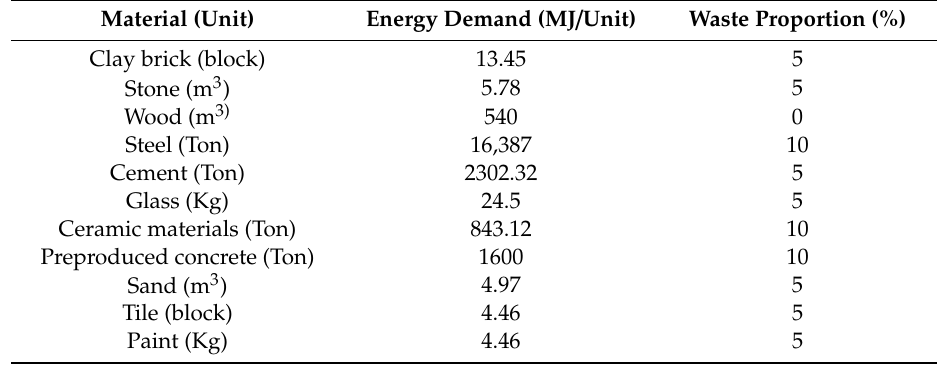
Table A2. Energy demand of manufacturing unit building materials and the waste proportion.